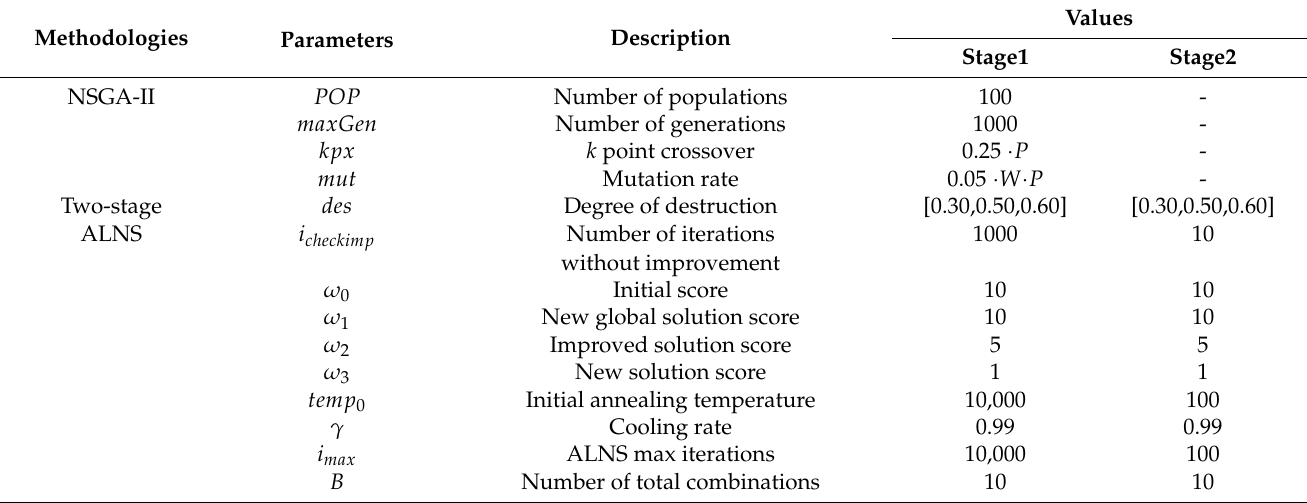
Table 15. Parameter settings for the proposed solution